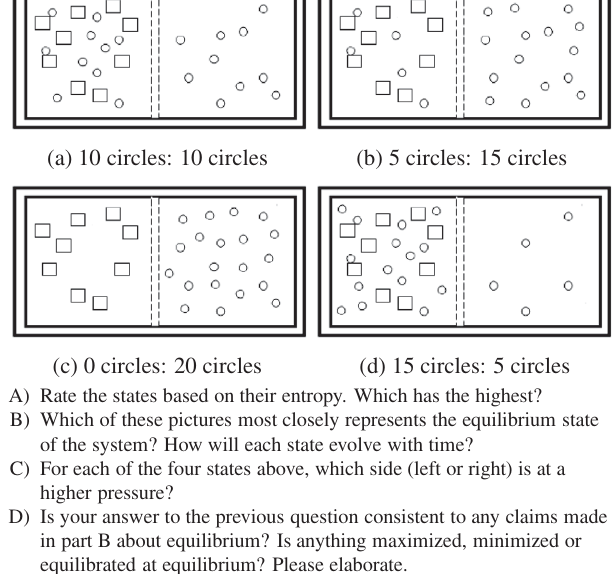
FIG. 1. The partitioned box question, the first interview question provided to students. Space was provided for students to show their